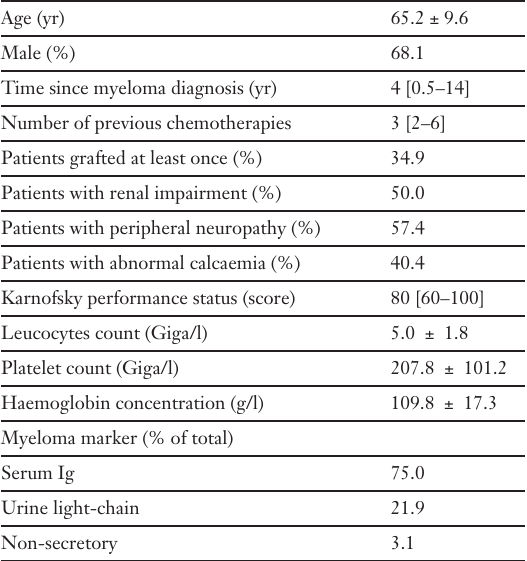
Patient and baseline characteristics. Means are expressed ± SD, median with [range].